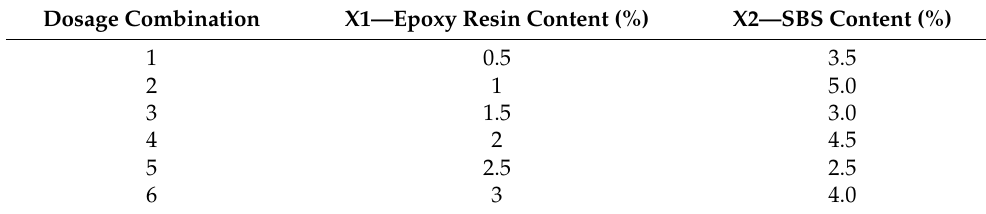
Table 7. Modifier dosage combination.